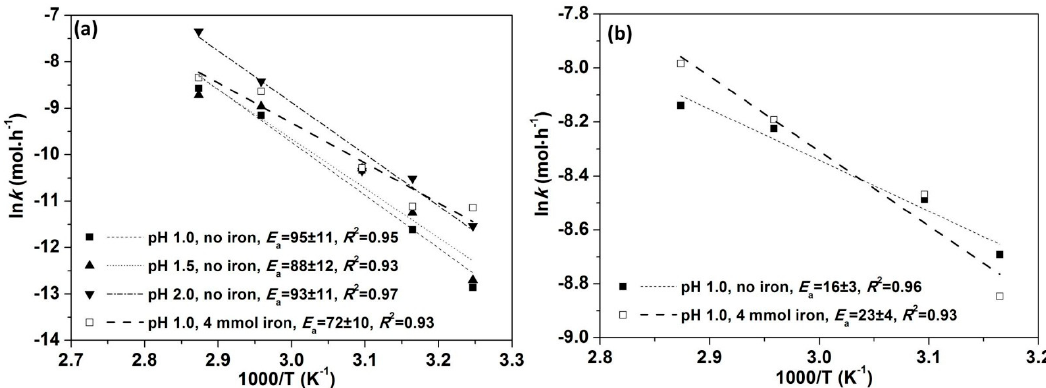
Figure 3. (cid:1831) (cid:2911) (kJ·mol − 1 ) calculation based on leaching with ( a ) <10% Cu extraction; ( b ) 20%–80% Cu extraction.